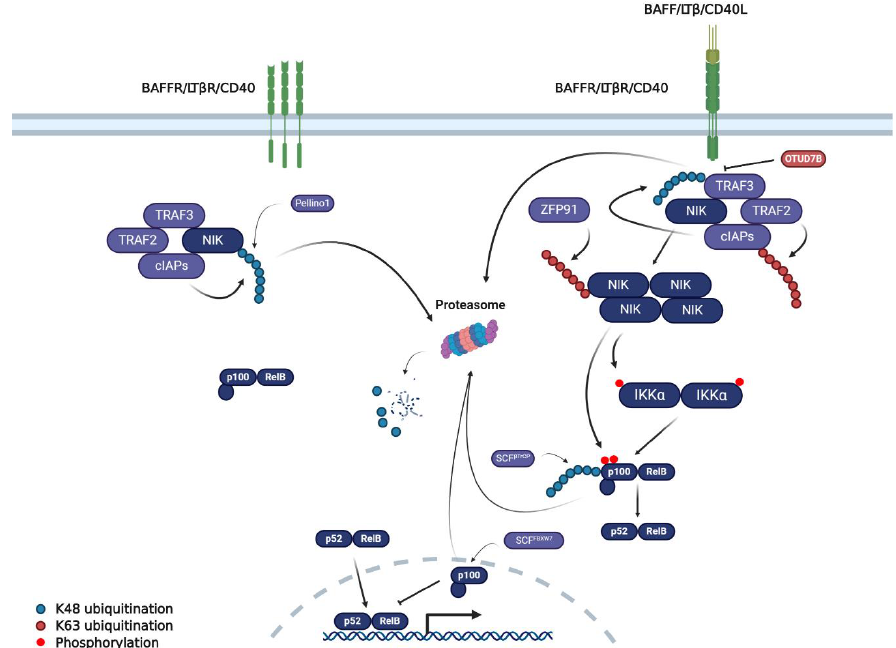
Figure 2. The non-canonical NF κ B signalling pathway and the role of ubiquitination. In the absence of ligand (left), the TRAF2 / TRAF3 / cIAP complex facilitates the proteasomal degradation of NIK. This results in the sequestration of RelB in the cytoplasm by p100, the precursor of the NF κ B protein pFollowing ligand: receptor engagement, TRAF3 is recruited to the receptor and is degraded by the combined functions of TRAF2 and cIAP1 / The loss of TRAF3 allows the accumulation of NIK, leading to the phosphorylation and activation of IKK α . IKK α then facilitates the partial degradation of p100, allowing the activated p52 / RelA heterodimer to translocate into the nucleus. The other proteins and ubiquitin linkages depicted in the figure are discussed in the text. For simplification, E2 ligases are not shown in the figure. Dark blue, core NF κ B pathway components; Purple, E3 ligases; Red,